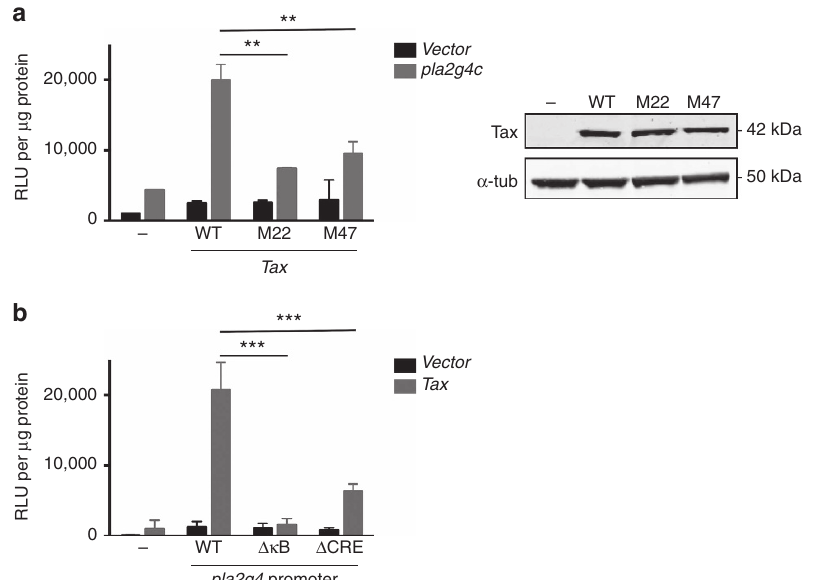
Figure 3 | Tax-induced pla2g4c expression depends on both NF- j B and CREB pathways. ( a ) Tax mutants fail to activate pla2g4c promoter. Pla2g4c promoter was cloned into a luciferase reporter plasmid. 293Tcells were transfected with the reporter plasmid (or the empty vector) and plasmids encoding Tax wild type (WT) or the mutants M22 (that do not activate the NF- k B pathway) or M47 (that do not activate the CREB pathway). Protein expression levels were detected by western blot 24h post transfection (right panel). Luciferase activity (relative light units, RLU) was normalized to the protein concentration. P value ¼ 0.001; n ¼ 4; mean ± s.e.m.; Two-way ANOVA, Sydak’s post hoc test. ( b ) The CRE and k B sites are both required for Tax-induced pla2g4c transactivation. 293T cells were transfected with a plasmid encoding Tax and with reporter plasmids with the luciferase gene downstream the WT pla2g4c promoter, or promoters depleted for the CRE or the k B sites (generated by site-directed mutagenesis). P value o 10 (cid:2) 4 ; n ¼ 4; mean ± s.e.m.; Two-way ANOVA, Sydak’s post hoc